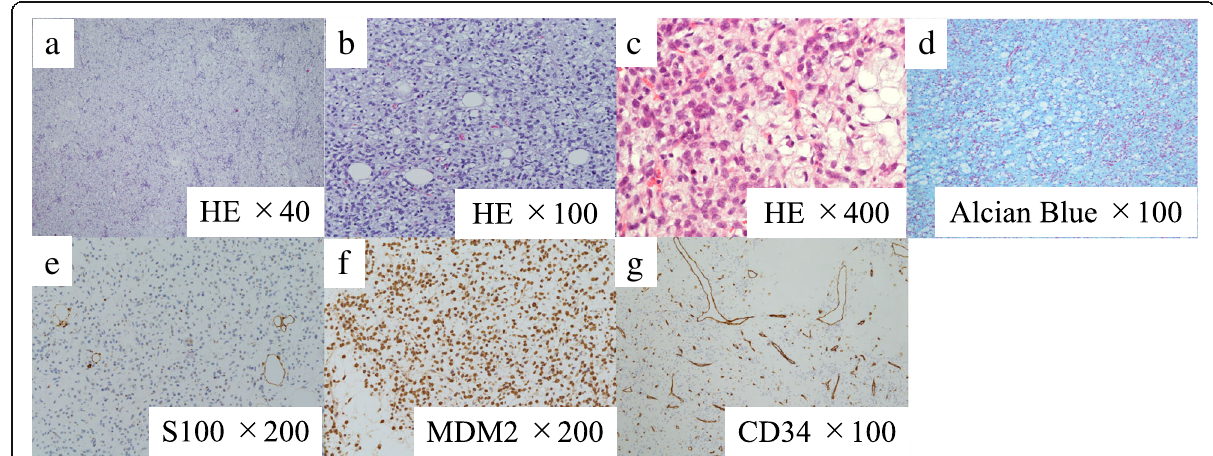
Fig. 7 Histopathological examination of the retroperitoneal tumor specimen. a , b Hematoxylin and eosin-stained sample showed almost the same character with the intra-abdominal tumor, suggesting they had the same differentiation status. c. Alcian blue staining for the mucinous component was positive. d – f Immunostaining with S100 and MDM2 was positive and negative with